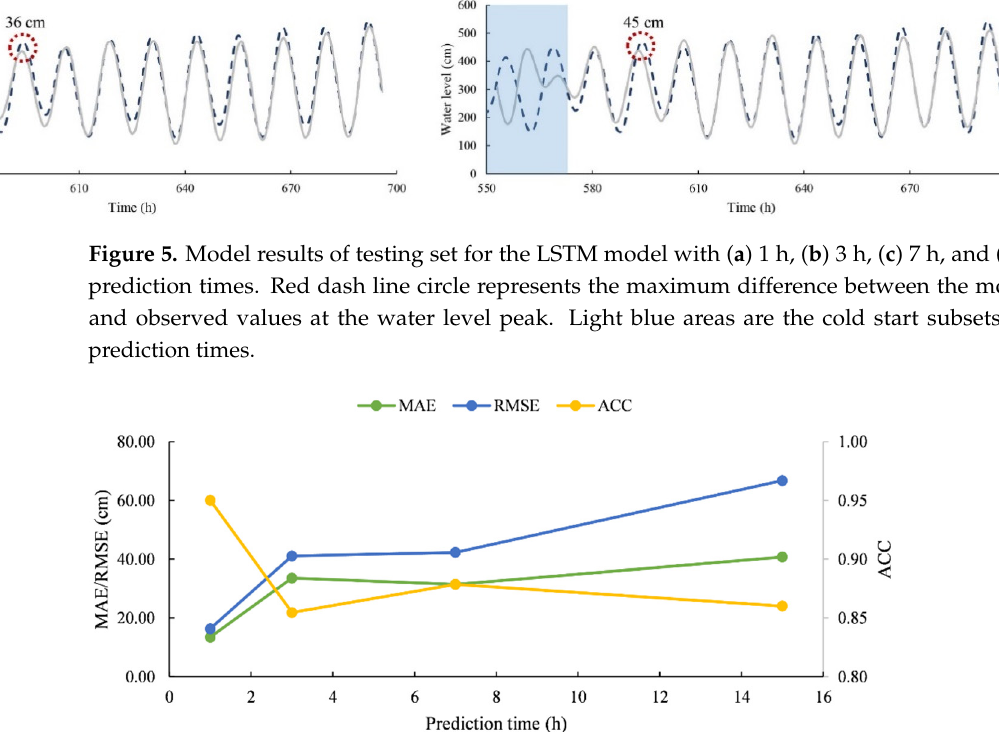
Figure 6. Model evaluation of testing set for the LSTM model with 1 h, 3 h, 7 h, and 15 h prediction times.